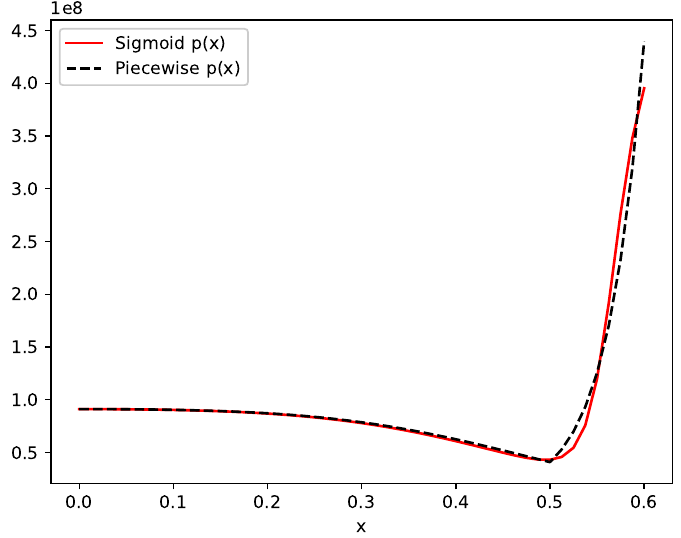
Figure 3. Concentration of platelets along the spatial domain at the final time.